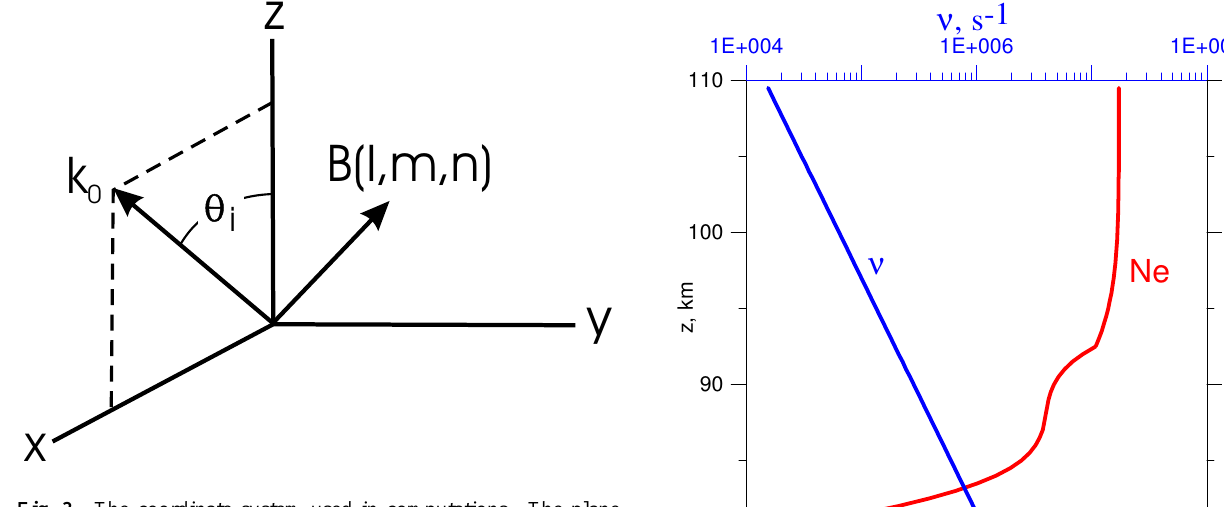
Fig. 3. The coordinate system used in computations. The plane of incidence is the x-z plane. The geomagnetic field B is directed along the ( l,m,n ) vector.